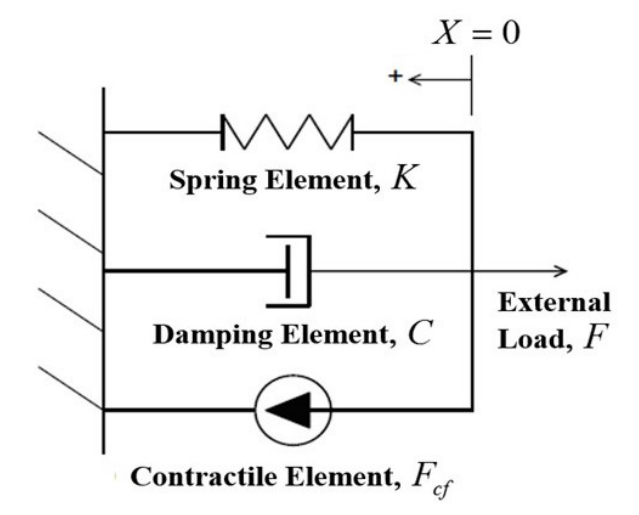
Figure 10. Biomechanical model of